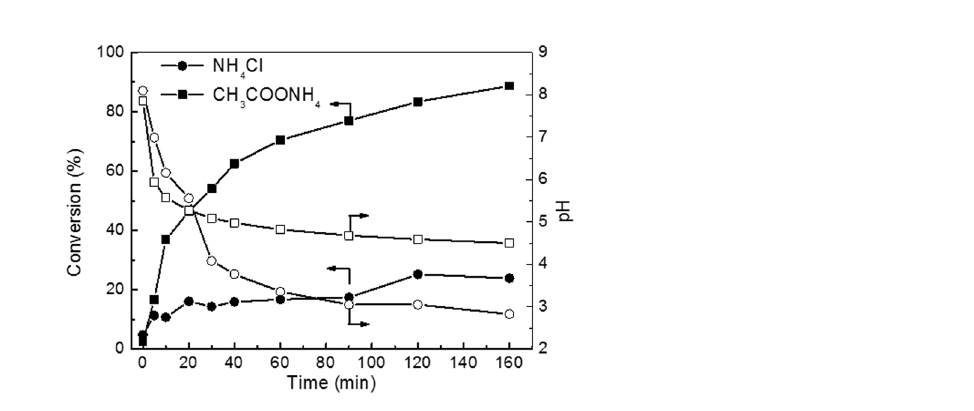
Figure 8. Ammonia conversion and pH after reaction of NH 4 Cl and CH 3 COONH 4 solutions over Ru-Cu/C, Pt/TiO 2 and Ru/TiO 2 catalysts. Conditions: [NH 4 + ] 0 = 1000 ppm, pH = 8.2, T = 200 o C, oxygen pressure = 2 MPa, reaction time = 3 h.